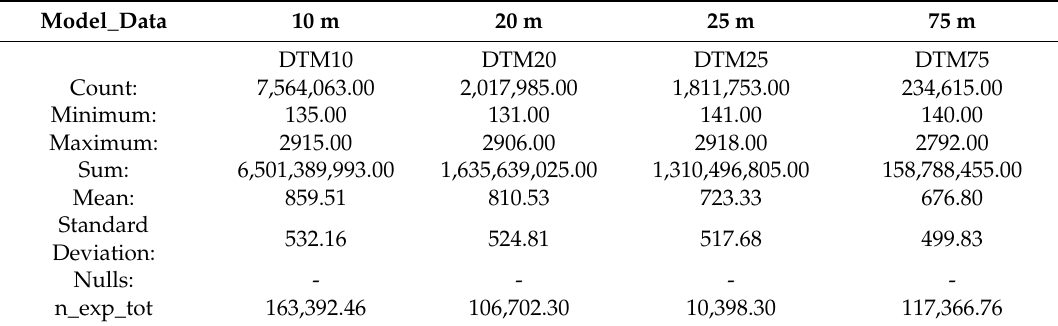
Table 4. Analysis of DEM indices and output generated by the nutrient retention model (n_exp_tot).